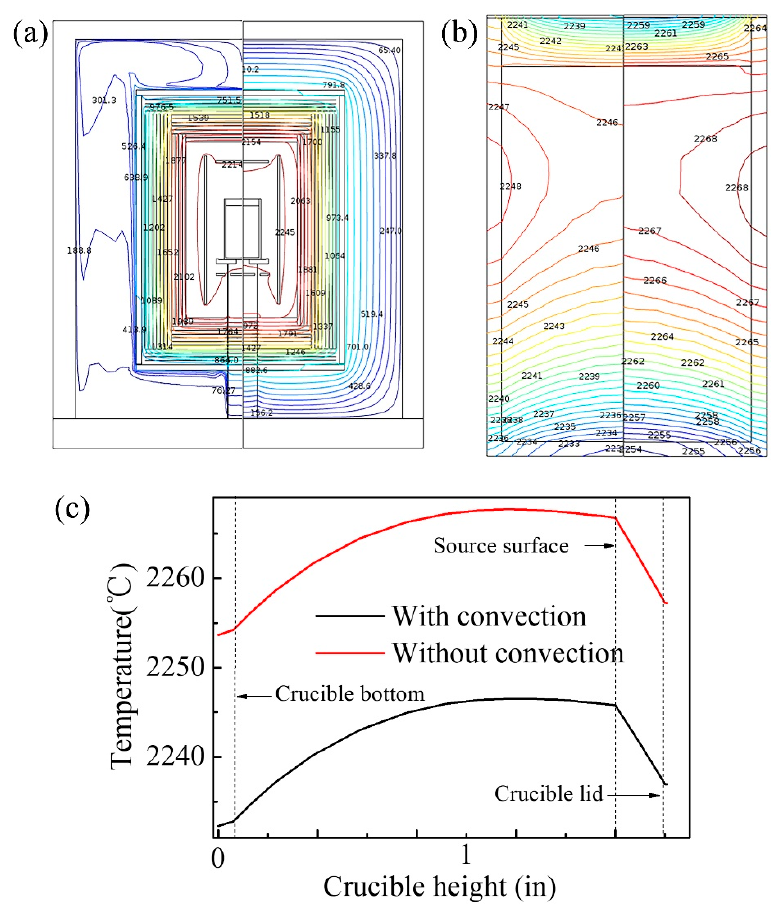
Figure 3. Results with (left) and without (right) gas convection. ( a ) Comparison of the entire equipment temperature distribution; ( b ) Comparison of the temperature isotherms of the tungsten crucible; ( c ) Comparison of the temperature profiles along the axis of symmetry of the crucible.